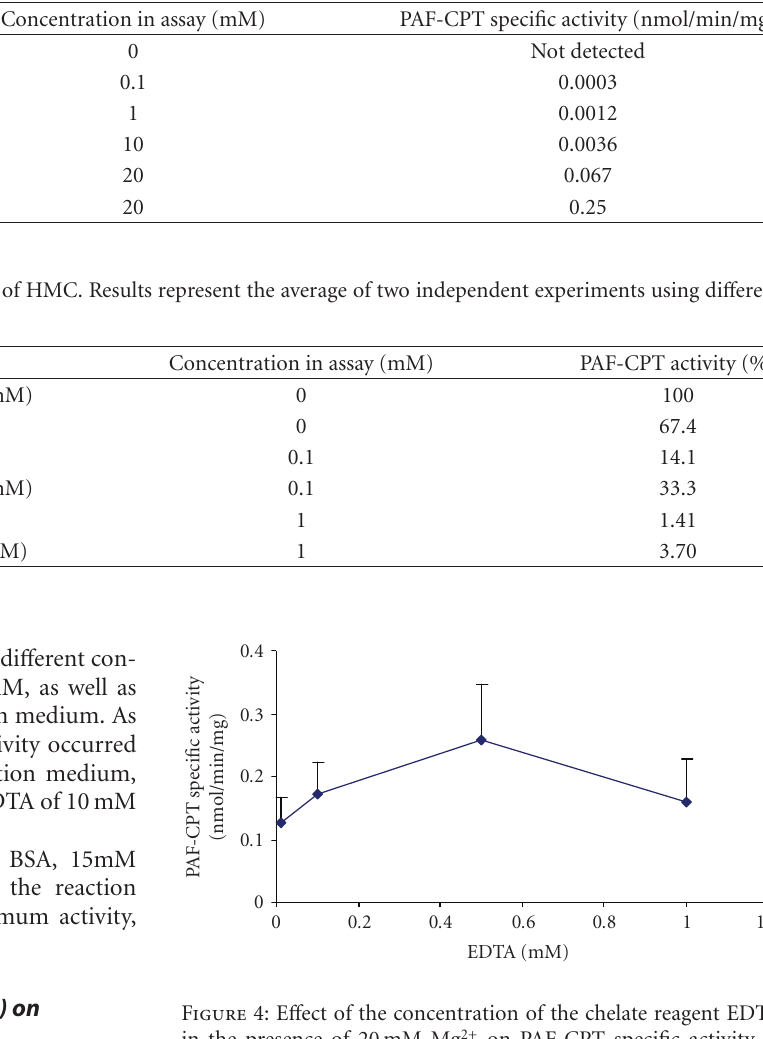
Table 2: E ff ect of Mg 2+ cation on PAF-CPT activity of HMC. Results represent the average of two independent experiments using di ff erent enzyme preparations performing duplicate samples.